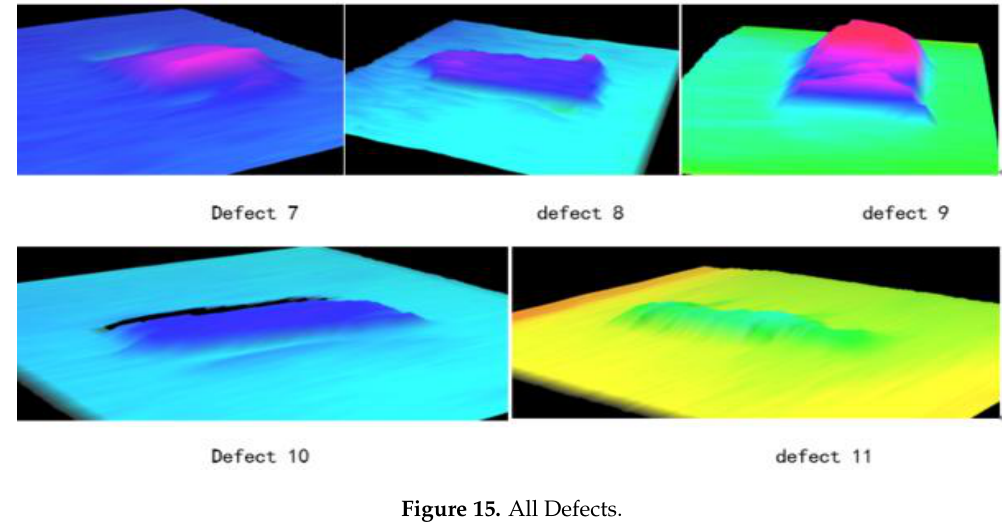
Figure 15. All Defects.